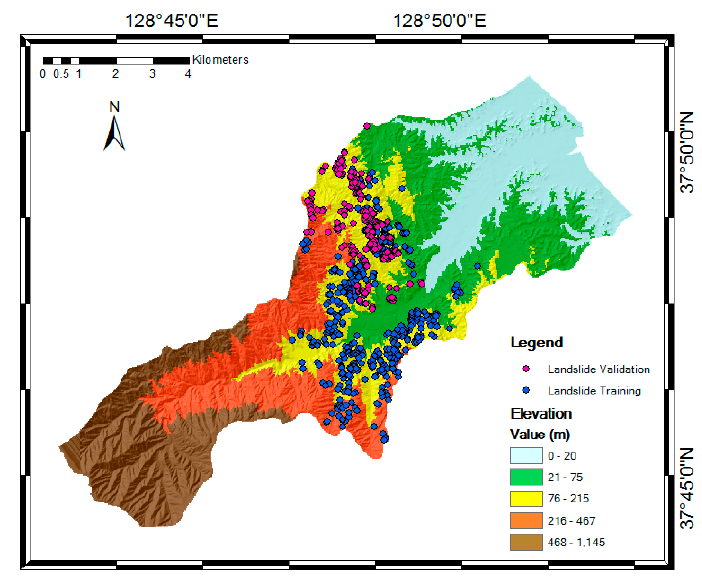
Figure 3. Digital elevation model and landslide occurrence in the study area.